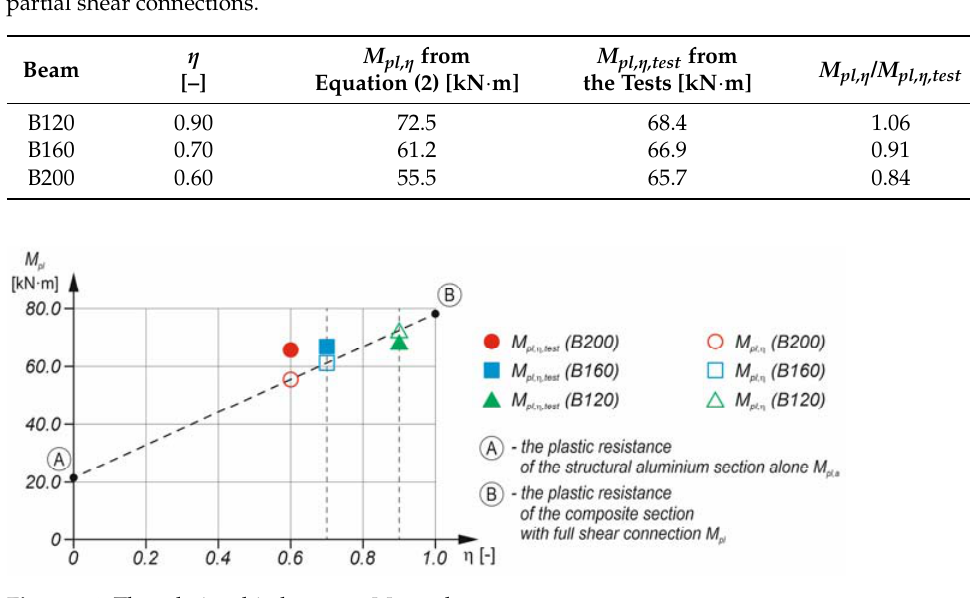
Figure 14. The relationship between M pl and η .